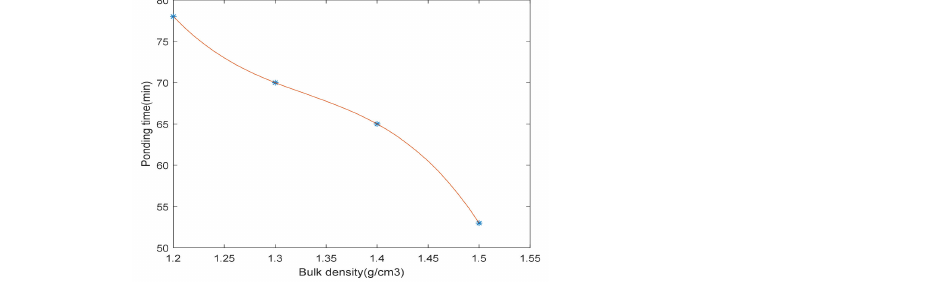
Figure 5. Relationship between bulk density and time of soil water accumulation. * is the data points of the finite element simulation, the red line is fitted through the data points.